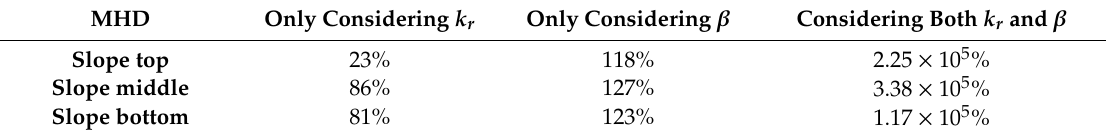
Figure 14. Variations in the maximum horizon displacement (MHD) at the different positions of the slope: ( a ) MHD of the top of the slope; ( b ) MHD of the middle of the slope; ( c ) MHD of the bottom of the slope. Table 3. Differences between only considering k r or β and considering both k r and β .